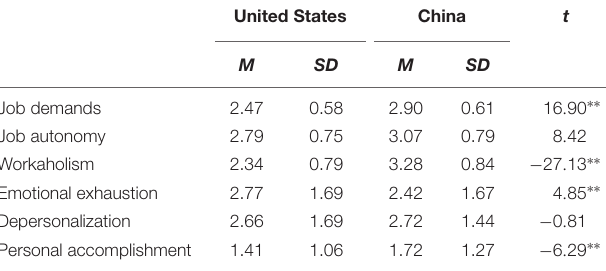
TABLE 2 | Comparison between China and the United States.